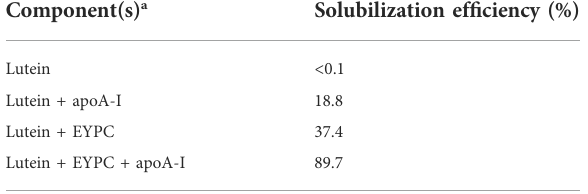
TABLE 1 Effect of ND formulation components on lutein solubility.